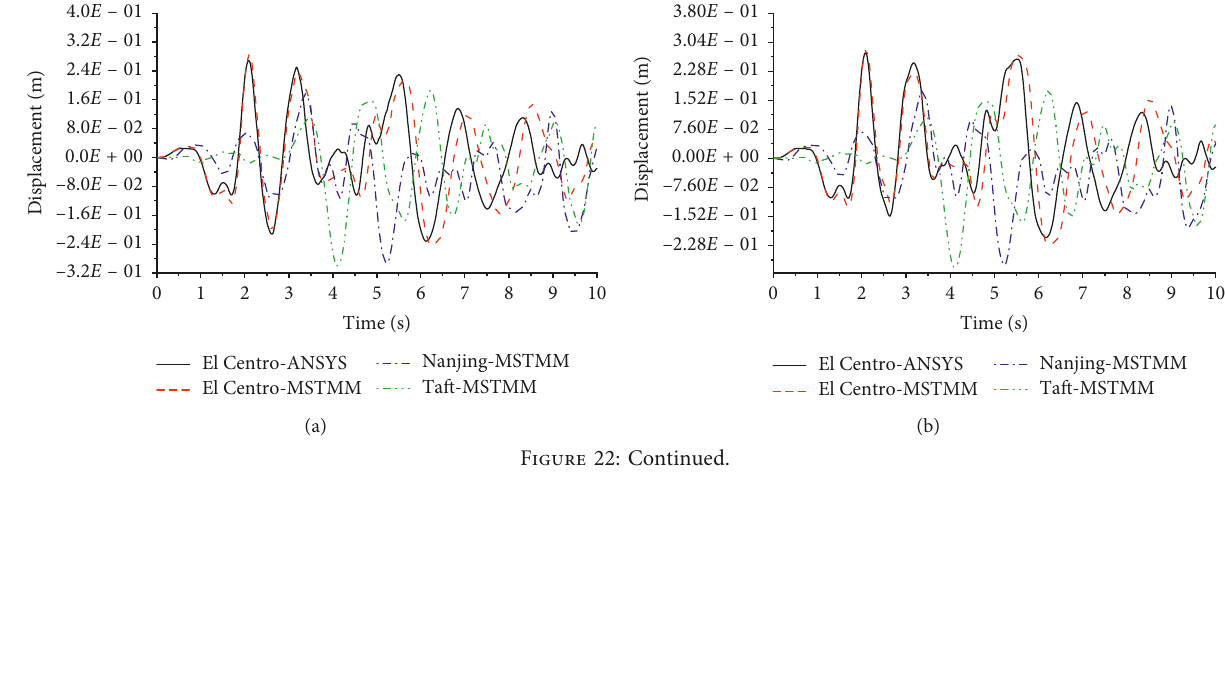
Figure 21: Time-history diagram of J (c) 150mm.